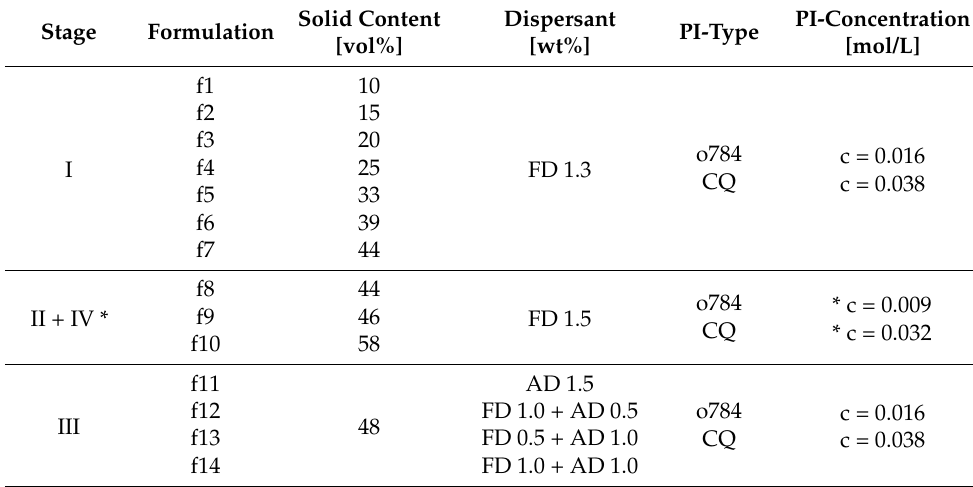
Table 1. Nomenclature of suspension formulations and investigation